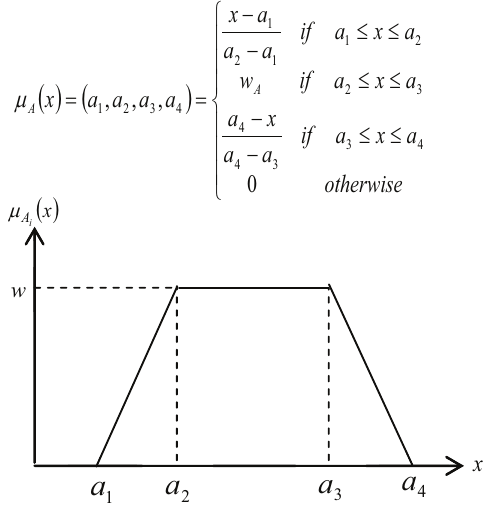
Fig 2: Generalised Trapezoidal Fuzzy